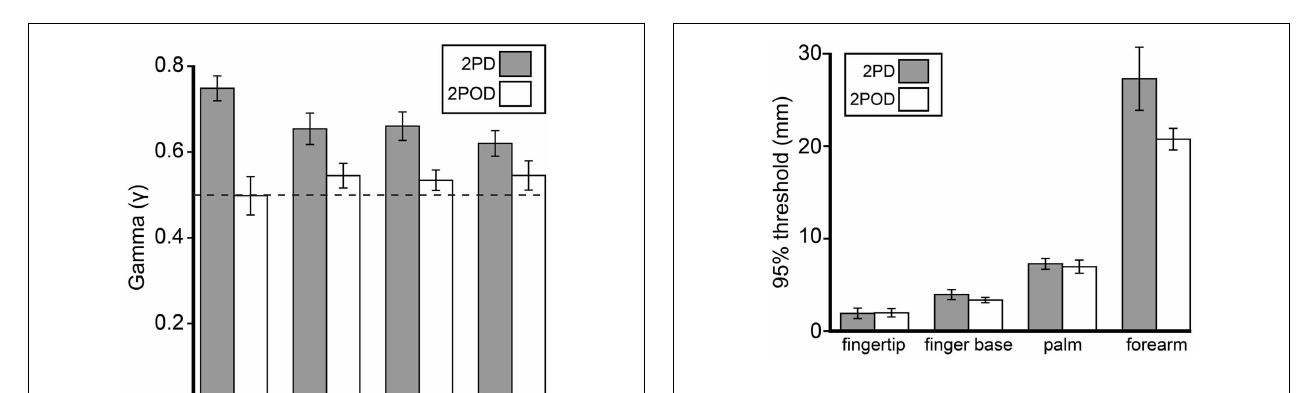
γ value was significantly above 0.5 on all body sites (all corrected p -values < 0.005). In stark contrast, the mean 2POD γ value did not differ significantly from 0.5 on any body site (all corrected p -values > 0.5). In contrast to the gamma parameter, the a and b -parameters did not differ significantly between tasks (separate two-way repeated-measures ANOVAs, p = 0.063 and 0.561 for main effects of task on a and b -parameters, respectively).